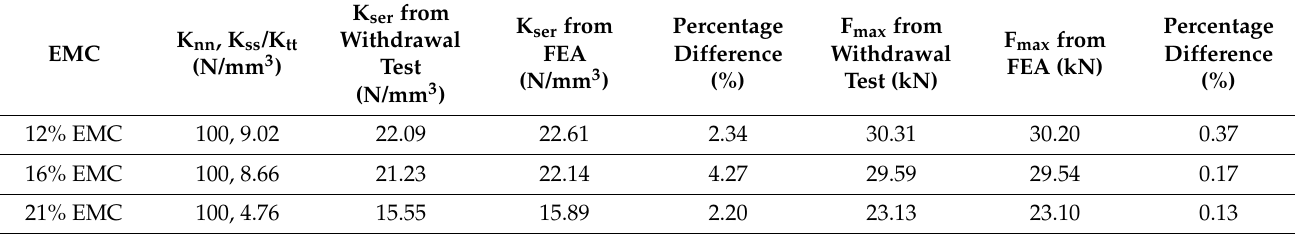
Table 16. 260 × 270 mm CLT calibrated values.